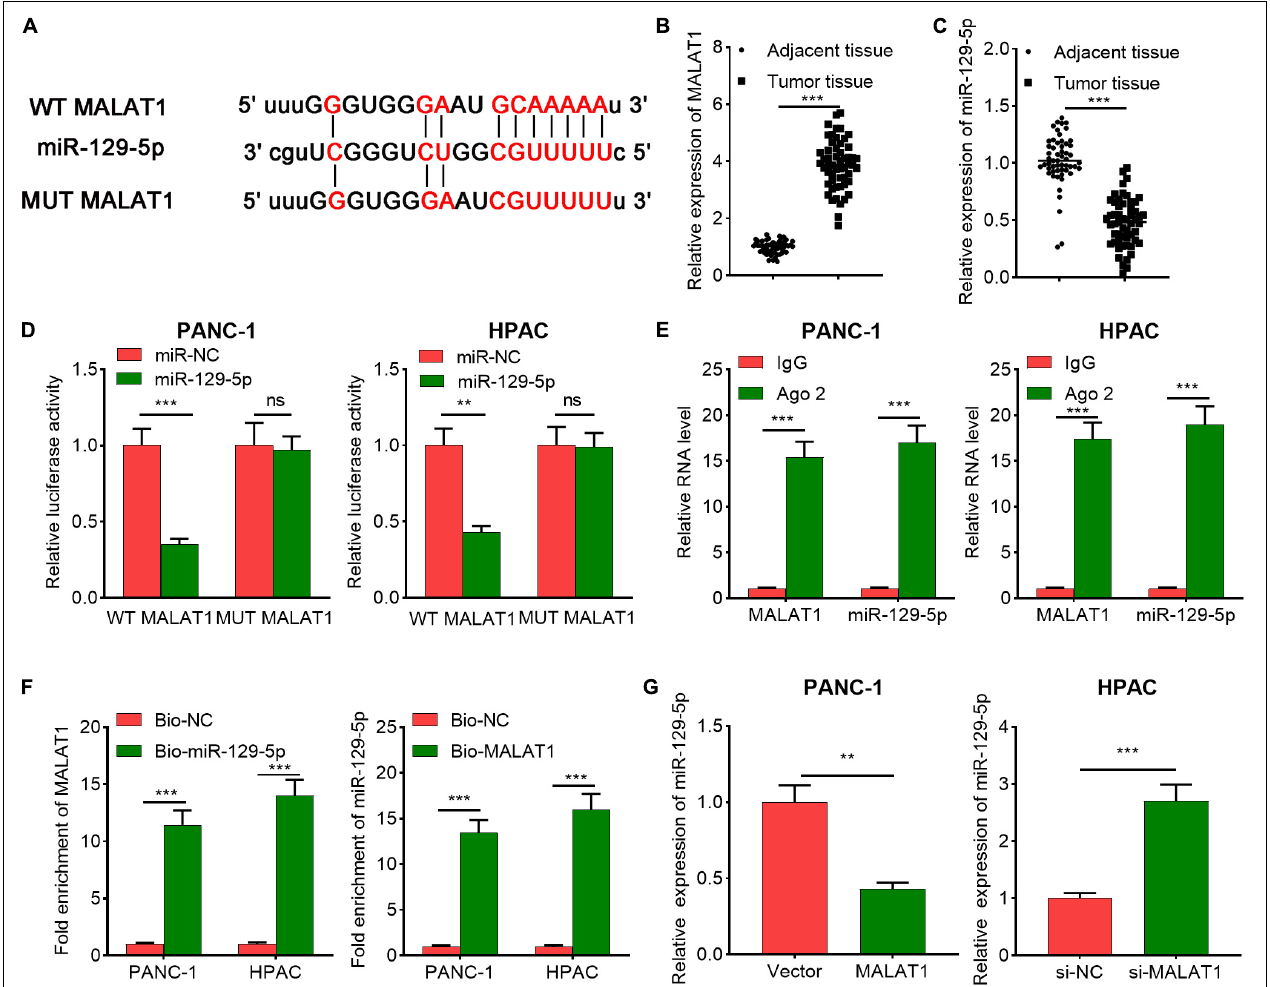
FIGURE 6 | The relationship between metastasis-associated lung adenocarcinoma transcript 1 (MALAT1) and miR-129-5p. (A) The predicted binding sequence between miR-129-5p and wide-type (WT) MALAT1 and the sequence of the mutant type (MUT) of MALAT1. (B) The expression of MALAT1 in pancreatic cancer tissue and adjacent tissue was detected by qPCR. (C) The expression level of miR-129-5p in pancreatic cancer tissue and adjacent tissue was measured by qPCR. (D) The binding site between miR-129-5p and MALAT1 was verified by dual-luciferase reporter assay. (E) RNA immunoprecipitation (RIP) assay was performed with immunoglobulin g (IgG) or Ago2 antibody in pancreatic cancer cells, and the co-precipitated RNA was used to perform qPCR for MALAT1 and miR-129-5p detection. (F) RNA pull-down assay confirmed that MALAT1 interacted with miR-129-5p. Relative enrichment of MALAT1 and miR-129-5p was measured using qPCR. (G) qPCR showed that MALAT1 could negatively regulate miR-129-5p expression in pancreatic cancer cells. ** p < 0.01, *** p <